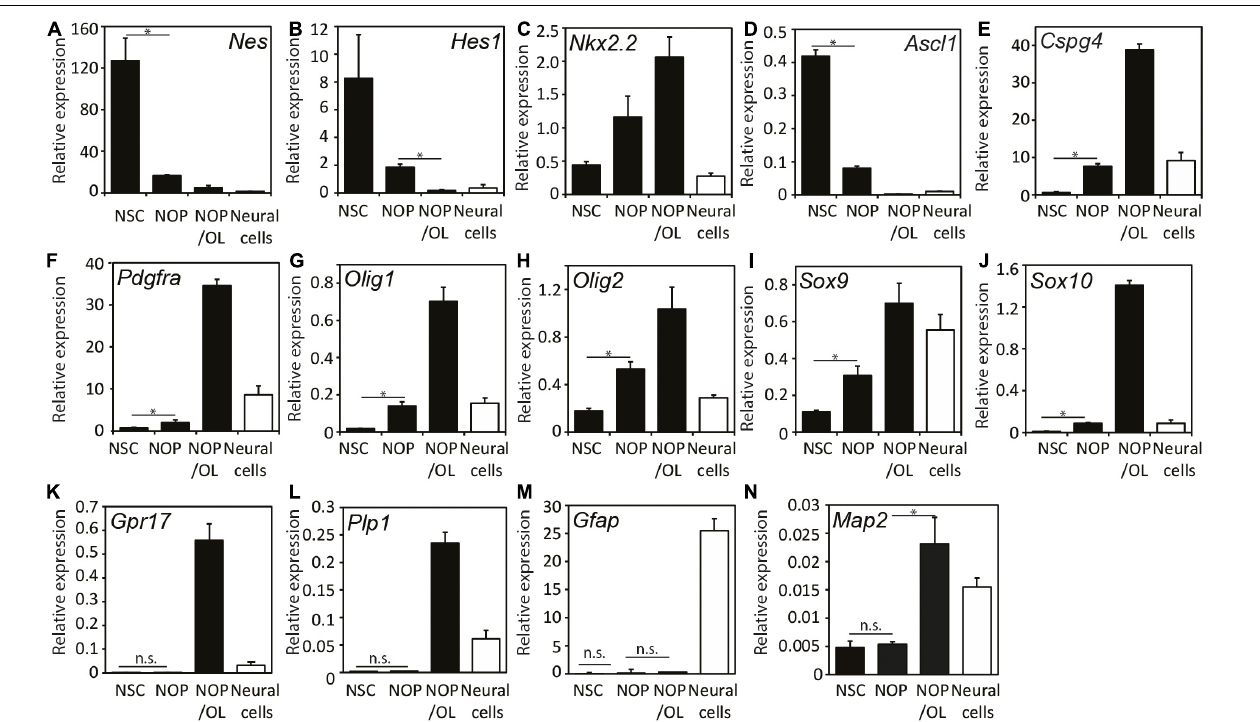
FIGURE 4 | Expression patterns of progenitor and neural lineage marker genes during oligogenesis from neural stem cells. Expression analysis of various genes including NSC-markers Nes (A) and Hes1 (B) , region-specific transcription factors Nkx2.2 (C) and Ascl1 (D) , OPC-markers Cspg4 (E) and Pdgfa (F) , OL-lineage cell markers Olig1 (G) , Olig2 (H) , Sox9 (I) , and Sox10 (J) , OPC/pre-OL marker Gpr17 (K) , OL marker Plp1 (L) , astrocyte marker Gfap (M) , and neuronal marker Map2 (N) . mRNAs were isolated from the cells after culturing in either OPC medium for NOP, or OL medium for differentiated NOP/OL, and relative gene expression was analyzed using quantitative real-time qPCR. Expression levels of each mRNA were normalized relative to that of GAPDH mRNA. Black bars indicate the expression level in three different population (NSC, NOP, and NOP/OL, and white bars show the expression levels in neural cells derived from NSC as control. Data are mean ± SD (bars) of three determinations. * P < 0.05; n.s., not